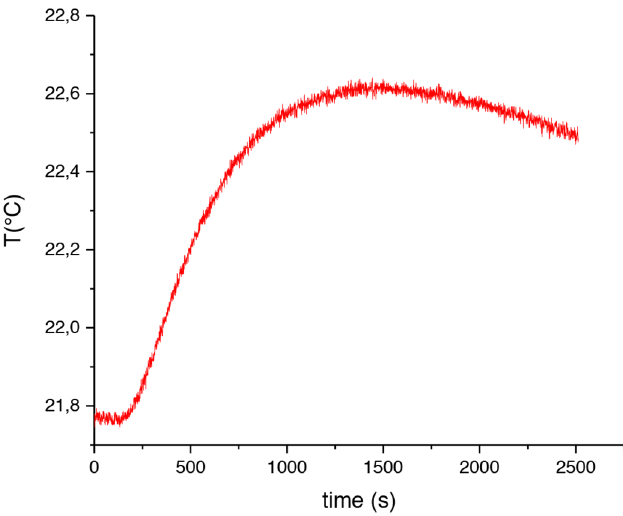
Fig. 5. Experimental thermogram of fl ash method.